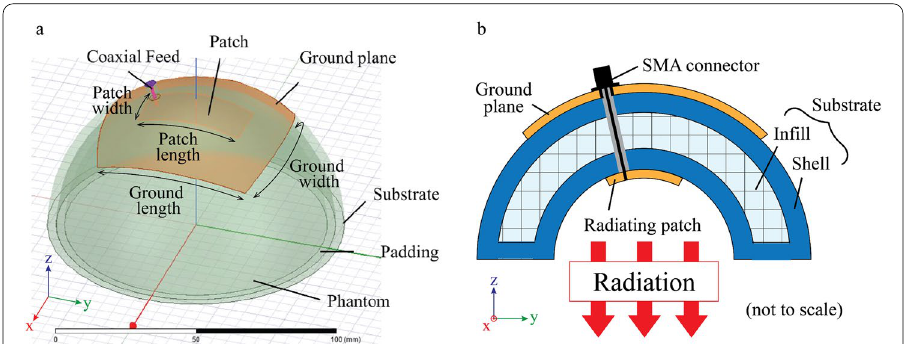
Fig. 2 Patch antenna in a perspective and b cross-sectional